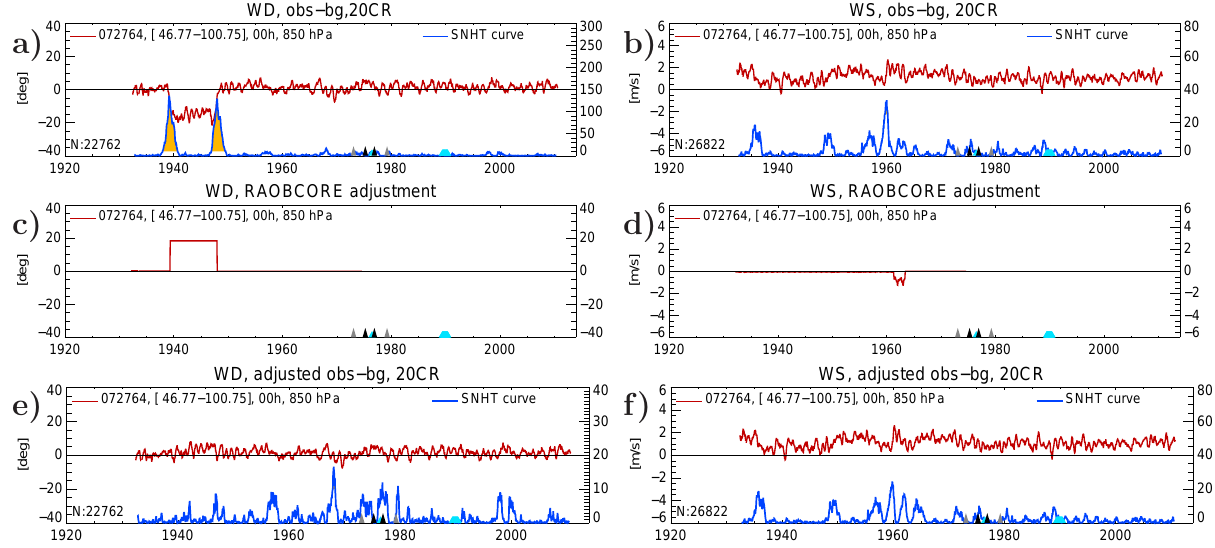
Figure 6. Upper row: (a) wind direction and (b) wind speed analysis departure (Obs-NOAA-20CR) time series at time 00:00UTC at 850hPa at station Bismarck (red curves). The blue curves (right axes) show the Q k time series as defined in Eq. (4). Q k values above Q crit = 10 are statistically significant and are shaded. The small colored triangles on the x axes indicate changes in the radiosonde type. For dd , Q crit has been set to 20. The mean of the wind speed differences is positive since NOAA-20CR wind speeds over the US are generally biased low. Metadata from IGRA are indicated as light blue trapezoids or triangles. Middle row: (c) wind direction and (d) wind speed adjustments calculated by RAOBCORE from analysis of the departure time series in upper row. Wind direction biases are constant in pressure and time between breakpoints. Wind speed adjustments occur only after 1960 at this station. They depend on observed wind speeds and are, therefore, not constant. Lower row: analysis departures after adding the adjustments in middle row to upper row. Note smaller right axis scales compared to the upper panel, indicating better homogeneity.